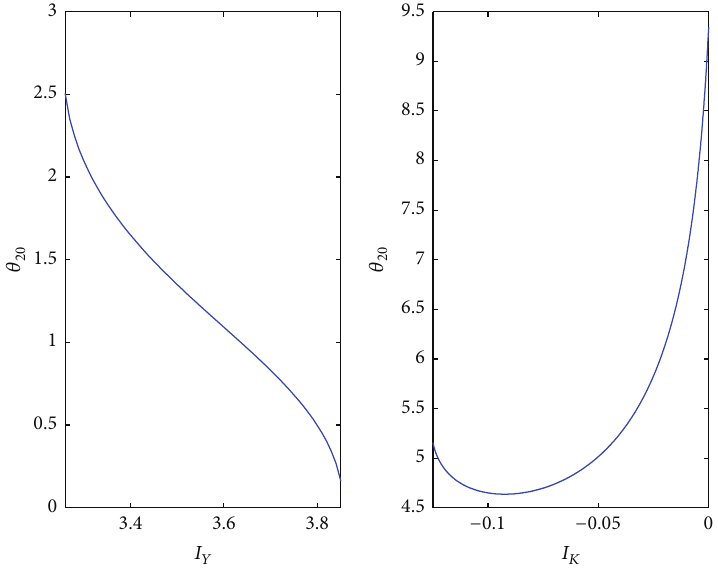
Figure 14: Crossing curve 𝜃 20 .